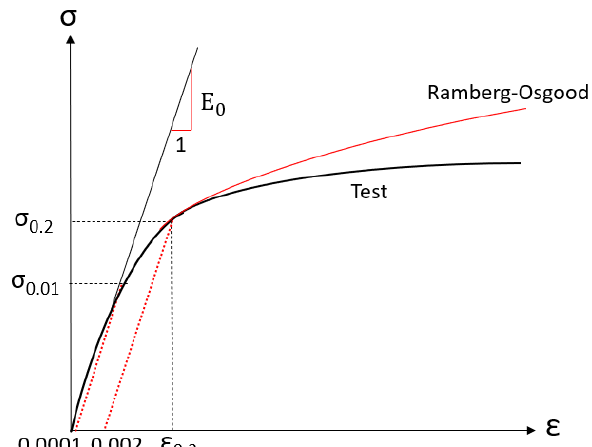
Figure 6. A schematic showing the typical RO stress-strain approximation for stainless steel alloys.